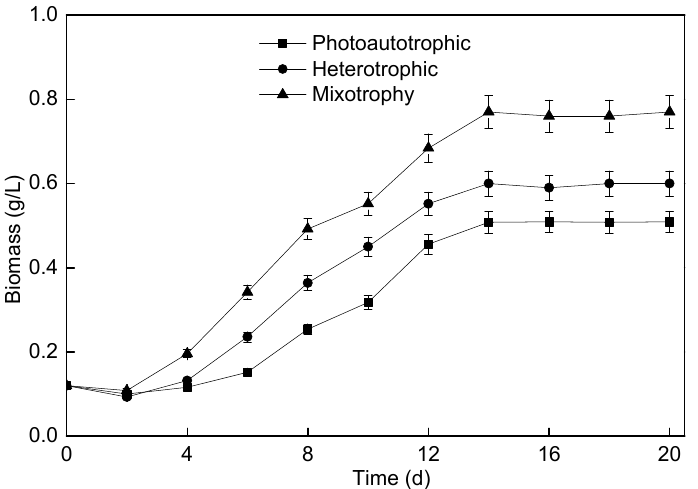
Figure 2. Changes in P. helgolandica tsingtaoensis biomass concentration under different culture modes.